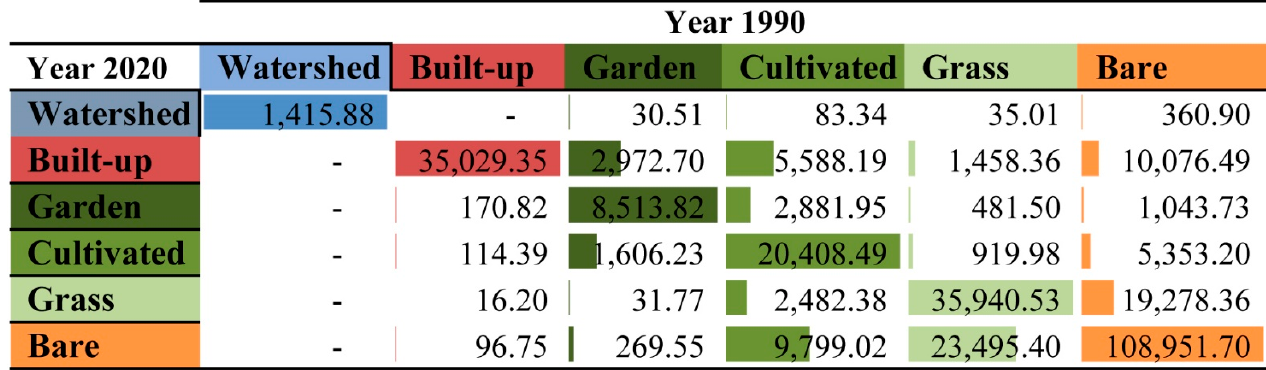
Figure 6. Transition area (Hectares).